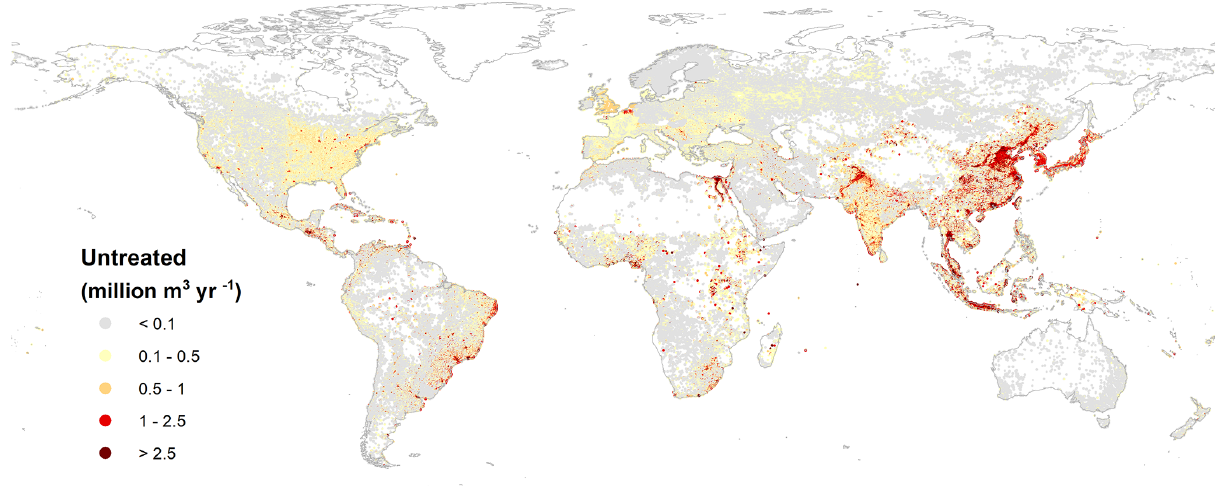
Figure 6. Gridded untreated-wastewater flows to the environment (10 6 m 3 yr − 1 ) at 5arcmin spatial